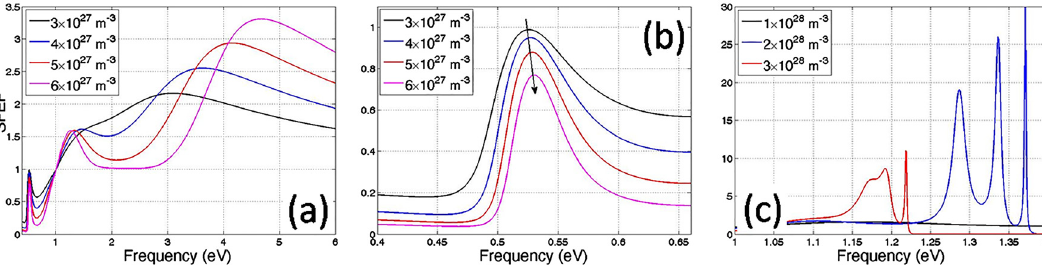
Figure 5: Squared-field enhancement factor vs carrier concentration at an incident field intensity of 40 MW/cm 2